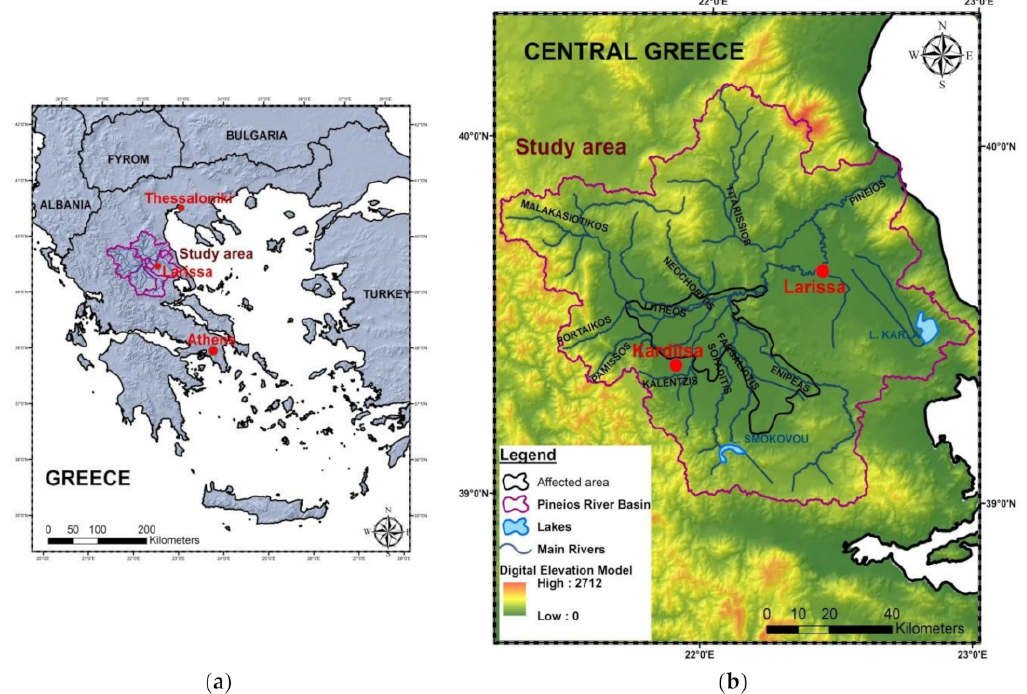
Figure 1. The study area located in Central Greece, with its principal geomorphological and hydrological characteristics. ( a ) Greece; ( b ) Central